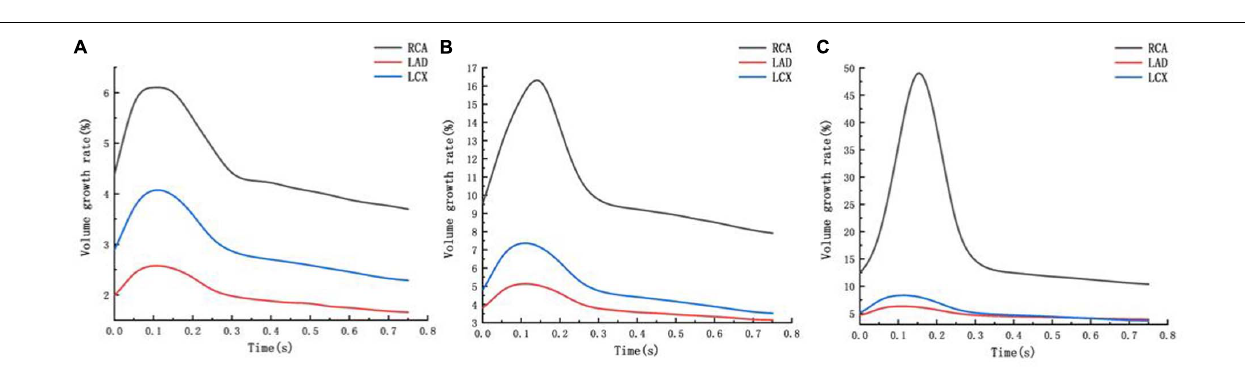
FIGURE 8 | Volume growth rate curve (A) normal condition (B) the Young’s modulus of the atherosclerotic site is 0.27MPa (C) the Young’s modulus of the atherosclerotic site is 0.027 MPa.